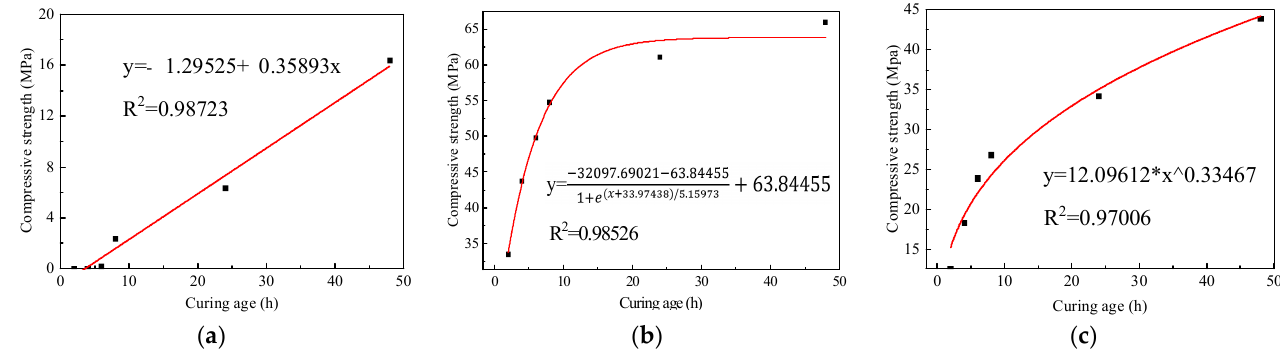
Figure 2. Fitting results of the strength of alkali-activated mortars under steam curing at 60 °C: ( a ) FZ60; ( b ) GZ60; ( c ) MZ60.